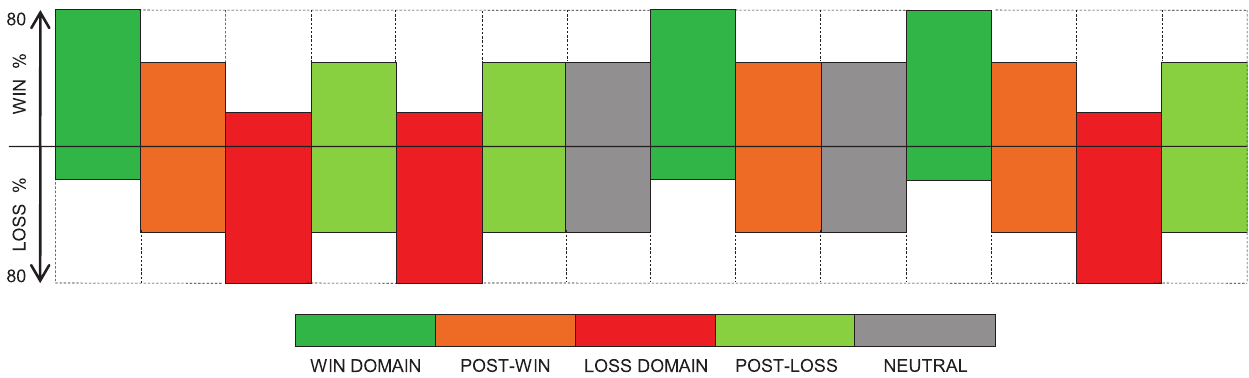
Figure 2. Example of a sequence of experimental blocks for one participant. In total, participants encountered 14 blocks with 32 trials each. The reward probability was manipulated within each block. The Win Domain (WD) block had a reward probability of 80% and the Loss Domain (LD) had a 20% reward probability. Blocks with a 50% reward probability followed WD and LD: Post-loss (PL) blocks always followed LD and Post-Win (PW) blocks always followed WD. The neutral blocks, which also had a reward probability of 50% did not represent a change in reward expectancy and were included in order to minimize the expectations that WD or LD blocks would necessarily appear after PW or PL blocks. A randomised sequence of three WD-PW block pairs, three LD-PL block pairs and two neutral blocks were presented to each